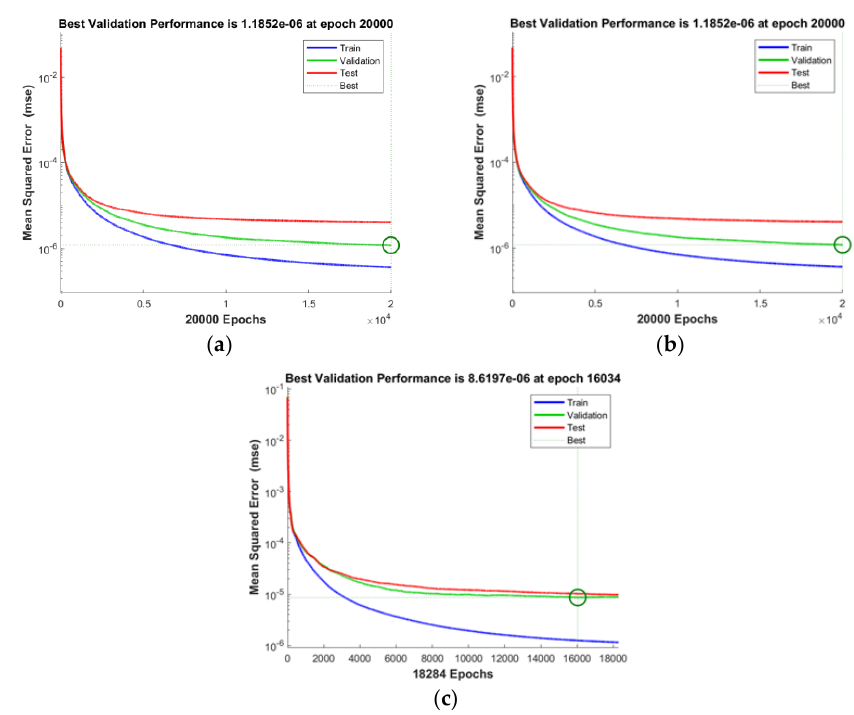
Figure 3. Learning curves of training the ANN model for ( a ) SDS = 0.22 mm, ( b ) SDS = 0.45 mm and ( c ) SDS = 0.73 mm, respectively. The green circles indicate the epochs number of best validation performance where the validation loss is the lowest.